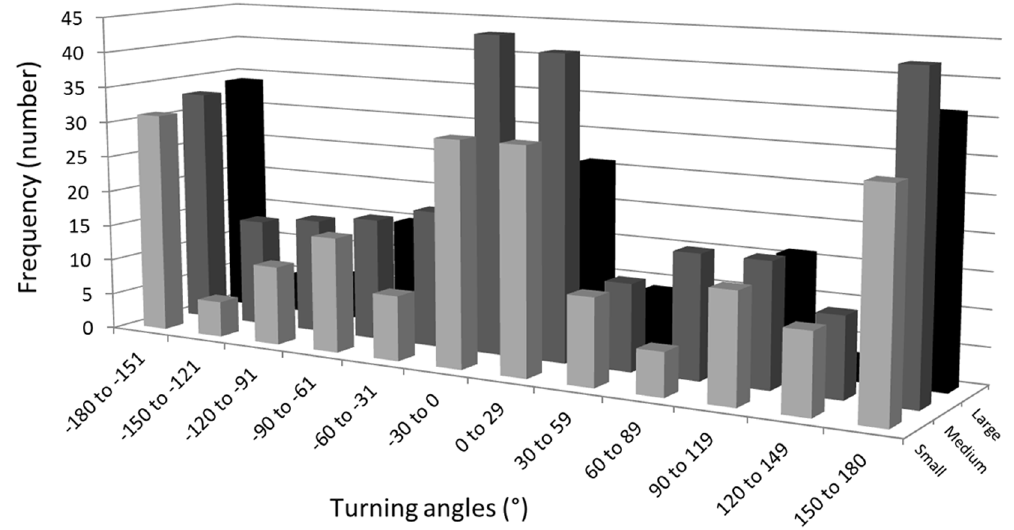
Figure 4. Distribution of turning angles for walking Colorado potato beetles. The frequency (number) distribution of turning angles (degrees) characterizing the movement of tagged adult Colorado potato beetles (pooled data) in small, medium, and large potato patches throughout the summer of 2012 in Fredericton.